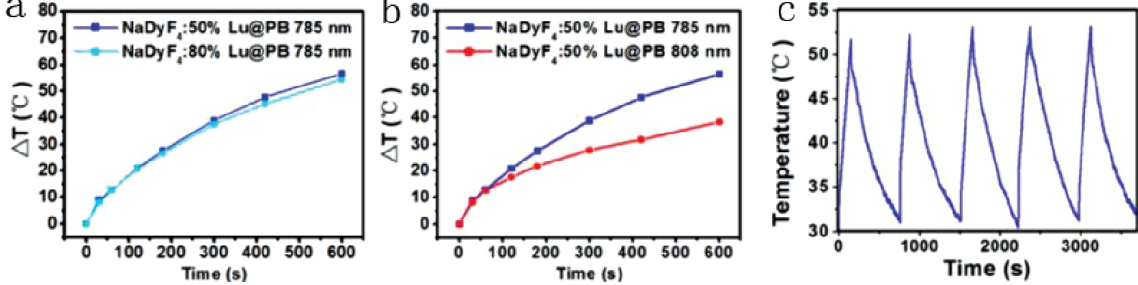
Fig. 8. (a, b)Heating curves of 200 mg mL-1 NaDyF :50%Lu@PB (785 nm), NaDyF :80%Lu@PB (785 nm), 4 4 andNaDyF :50%Lu@PB (808 nm) under laser irradiation at the power density of 1.33 W cm -2 , respectively. 4 (c) Temperature variations of NaDyF :50%Lu@PB (200 mg mL -1 ) under the continuous irradiations of 785 4 nm laser for five cycles. Reprinted with permission from Y. Liu, Q. Guo, X. Zhu // Adv Funct Mater 26 (2016) 5120. Copyright 2016 WILEY-VCH Verlag GmbH & Co. KGaA, Weinheim.